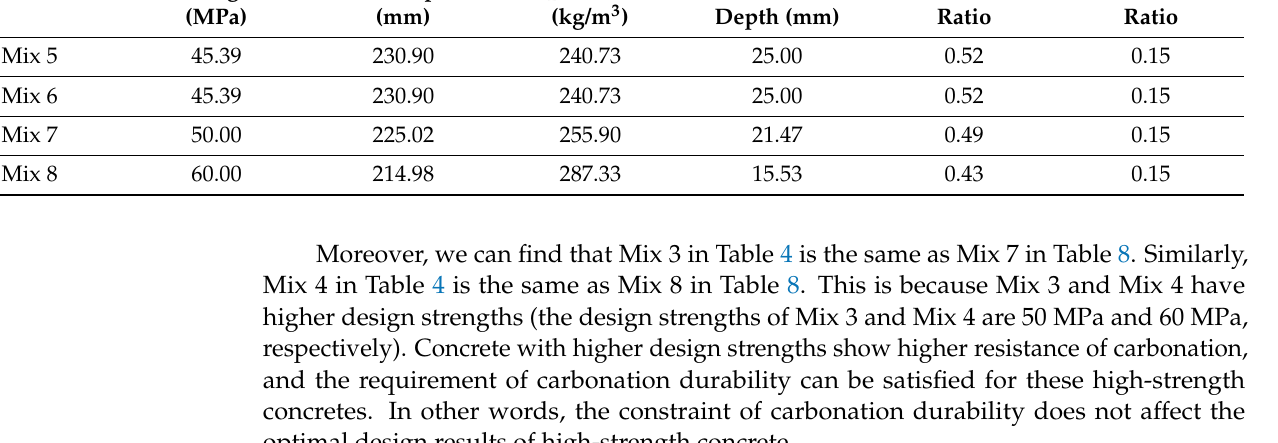
Fine Coarse Superplasticizer Aggregate Aggregate